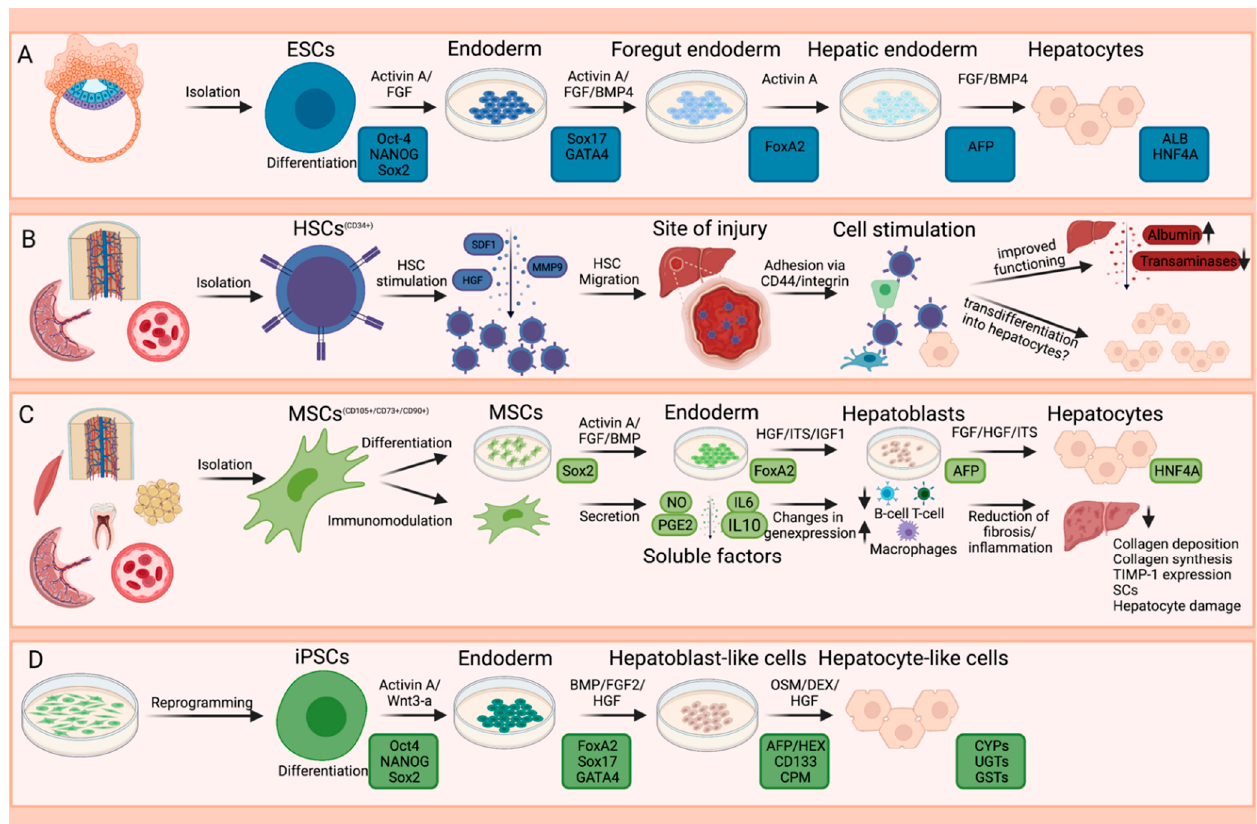
Figure 2. Different sources of stem cells and their mechanism of differentiation for cell-based therapies. ESCs ( A ) are isolated from the early blastocyst [61]. The sources of HSCs ( B ) and MSCs ( C ) include placenta, umbilical cord, bone marrow, and peripheral blood; for MSC, additionally, dental pulp, muscle, and adipose tissue can be utilized [60,83]. iPSCs ( D ) are derived from somatic cells by a reprogramming step. Triggered by different transcription and growth factors, all of them can be differentiated into hepatocytes.